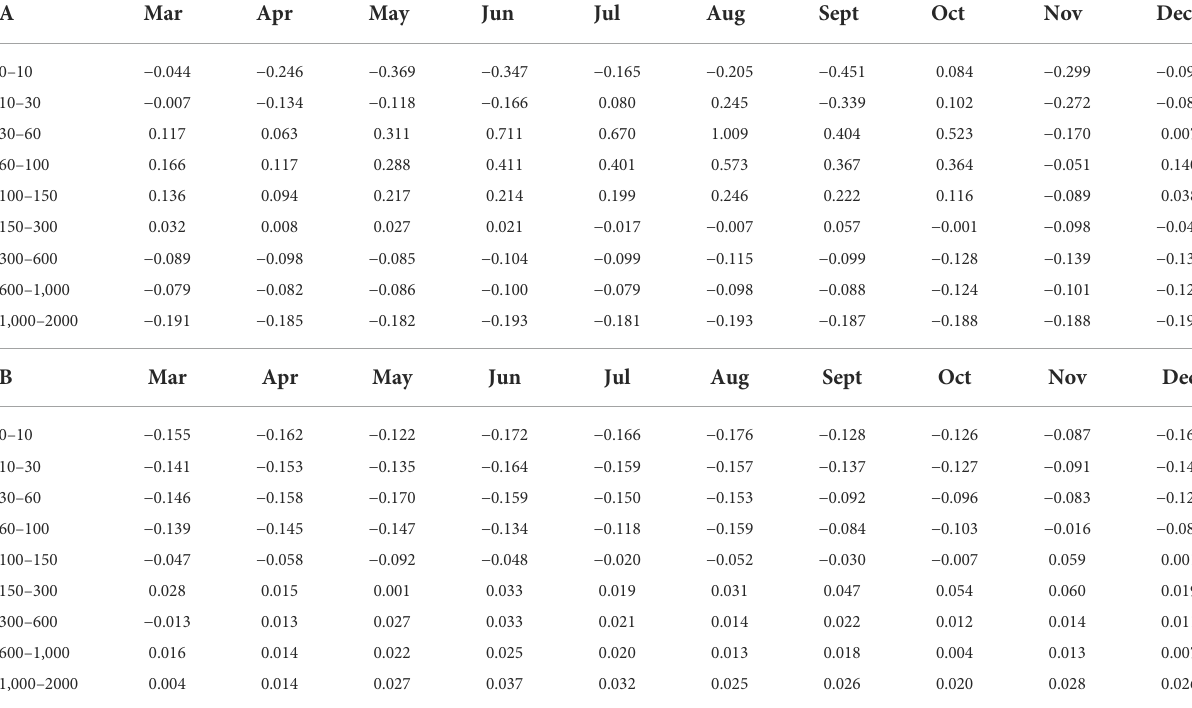
TABLE 3 Bias (MITO-observation) for temperature (A) and salinity (B): monthly variability. The nine reference layers considered are indicated in the fi rst column.